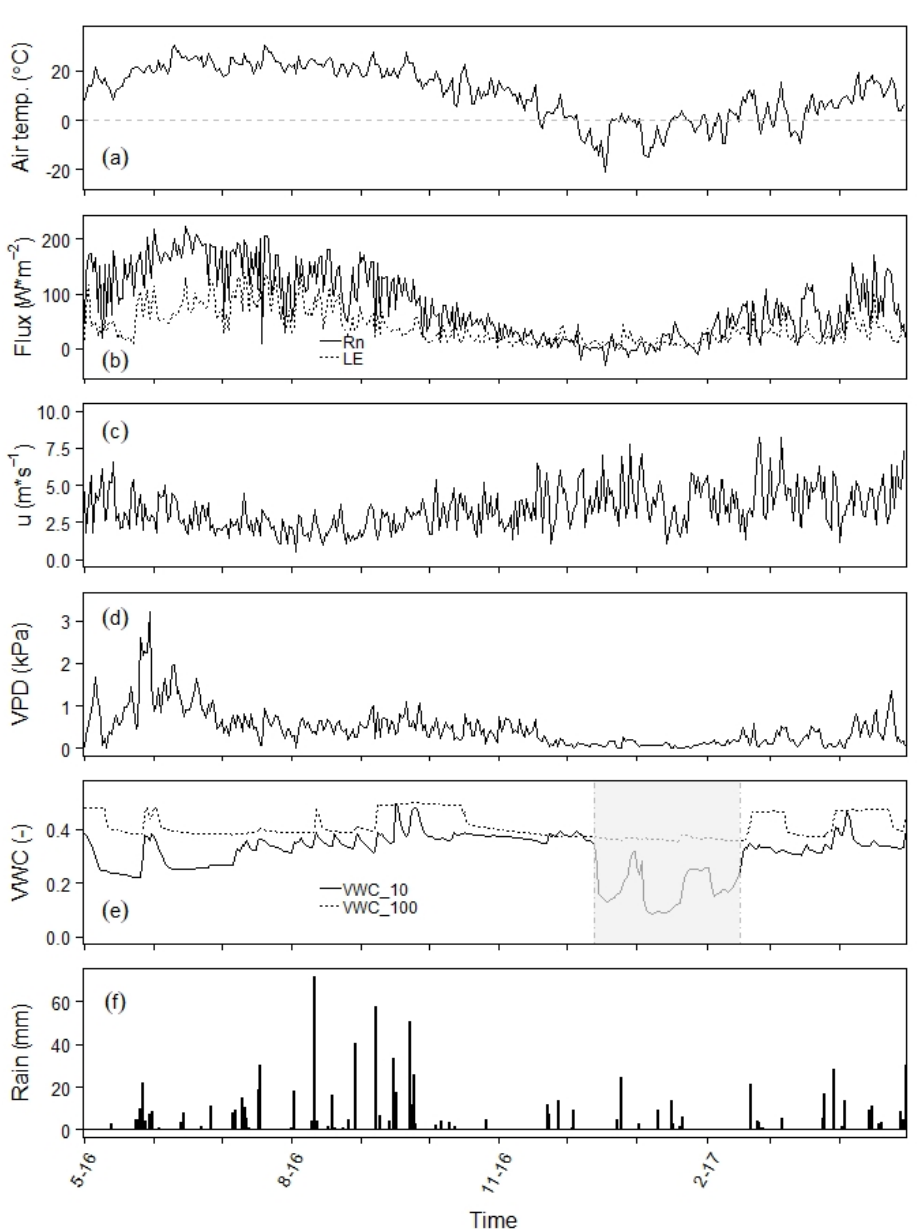
Figure 2. Selected field measurements of ( a ) averaged air temperature at approximately 2 m above ground ( ◦ C), ( b ) averaged net radiation ( R n ), and latent heat flux (LE) (W m − 2 ), ( c ) averaged wind speed at approximately 2 m above ground (u, m s − 1 ), ( e ) averaged volumetric water content (VWC, unitless) measured at 10- and 100-cm depths, ( f ) total rainfall (mm), and a derived value of ( d ) VPD (vapor pressure deficit, kPa) on a daily time scale between 1 May, 2016 and 30 April, 2017 at Tower 11. The gray area in ( e ) represents the time when the surface soil was frozen (soil temperature at 10 cm below the ground surface < 0 °C). Table 1 indicates that EBR from both towers was less than 0.8 for the entire study period and a little less than 0.75 during crop-growing season. However, the EBR values were higher during no-